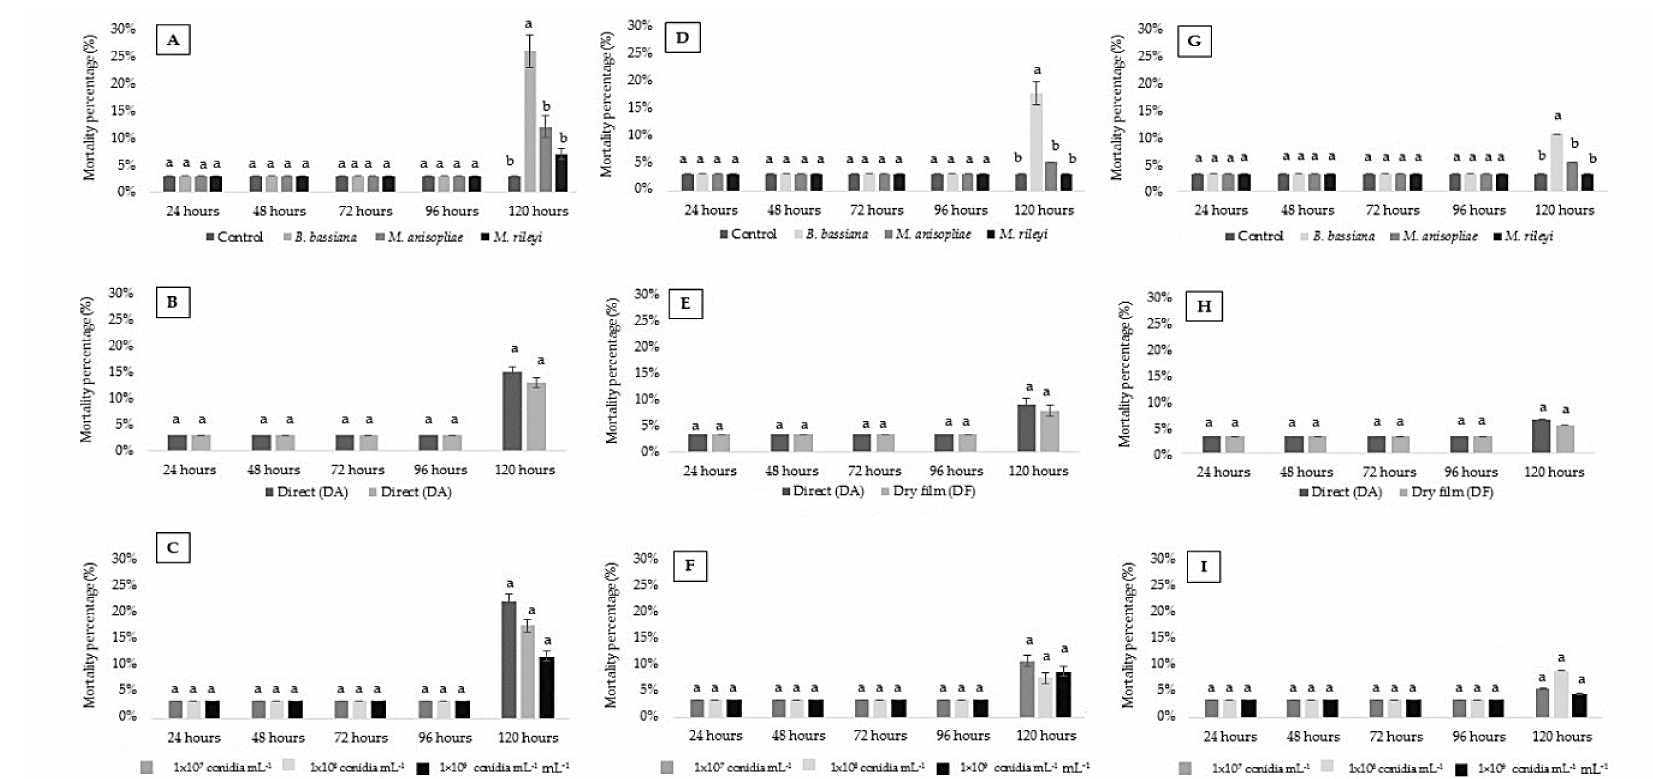
Figure 1. Mortality percentage (% ± standard error) of the first, second and third Chrysoperla externa larvae after each period of application of entomopathogenic fungi Beauveria bassiana , Metarhizium anisopliae and Metarhizium rileyi (T: 25 ± 1 ◦ C, RH 70 ± 10% and 12 h photoperiod (light / dark)). ( A – C ) First instance mortality factor = P (products), A (application methods) and C (concentrations), respectively. ( D – F ) Second instar mortality factor = P (products), A (application methods) and C (concentrations), respectively. ( G – I ) Third instar mortality factor = P (products), A (application METHODS) and C (concentrations), respectively. Values (%) followed by equal letters at each assessment time do not di ff er from each other according to a Tukey test at 5%